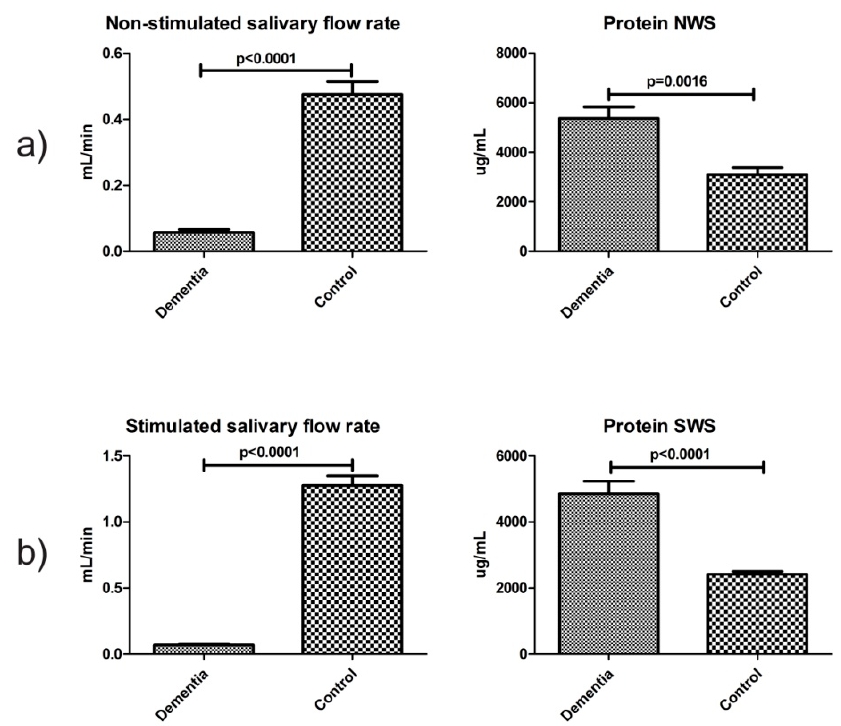
Figure 1. Salivary flow and total protein in non-stimulated ( a ) and stimulated ( b ) saliva of dementia patients and control group. Abbreviations: NWS, non-stimulated whole saliva; SWS, stimulated whole saliva .